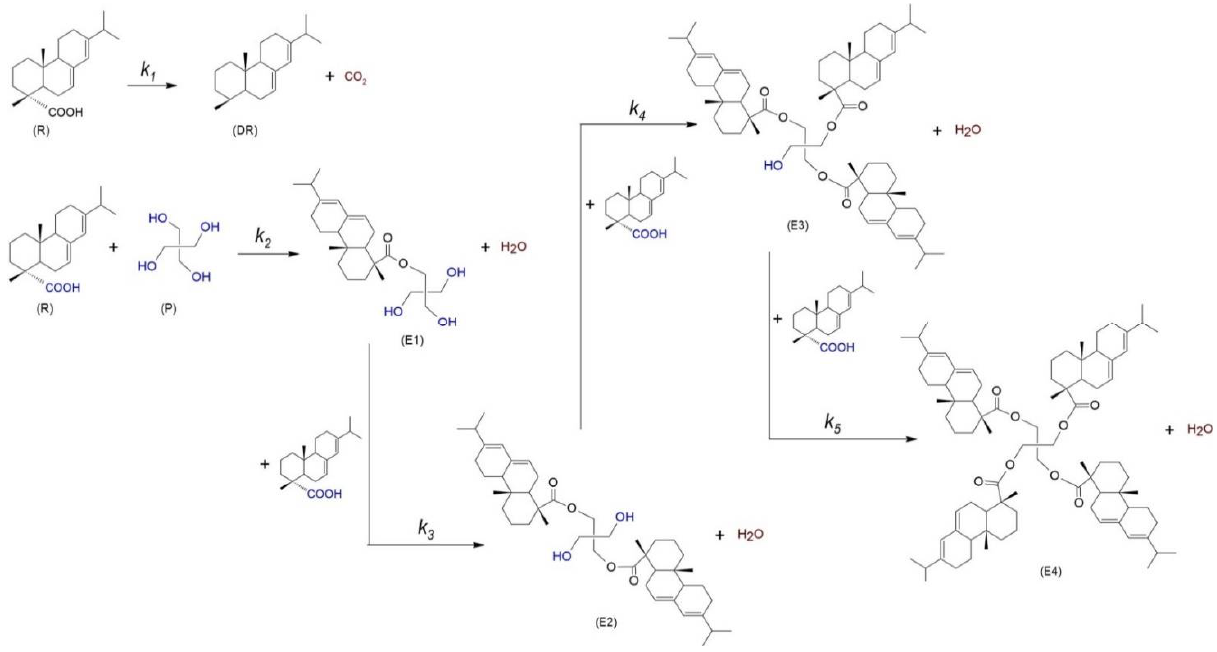
Figure 1. The reaction scheme of esterification of rosin and pentaerythritol.